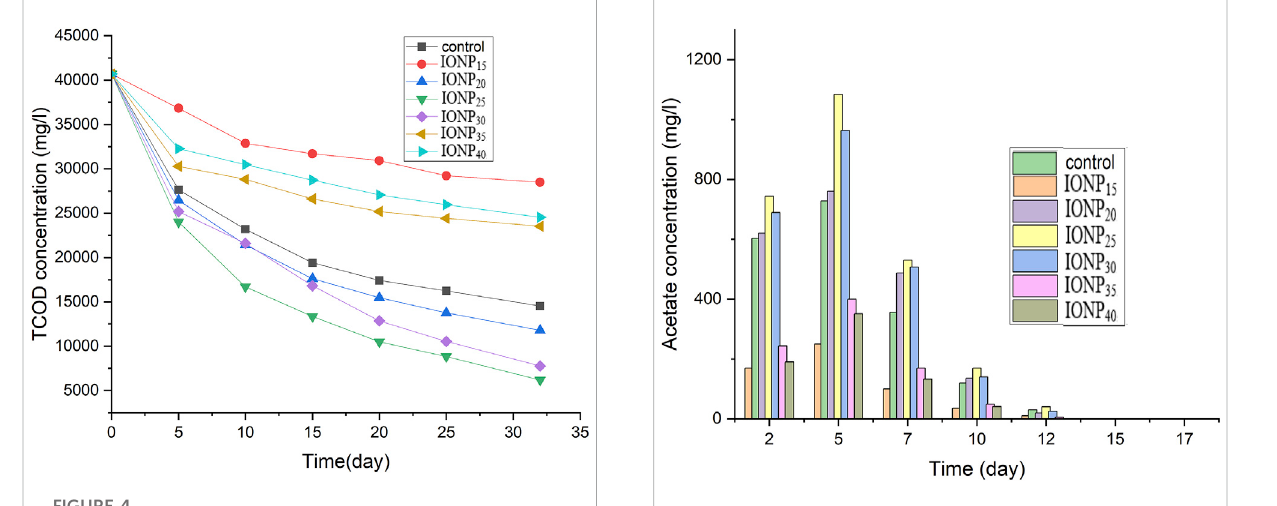
FIGURE 5 Effect of different doses of IONP acetate